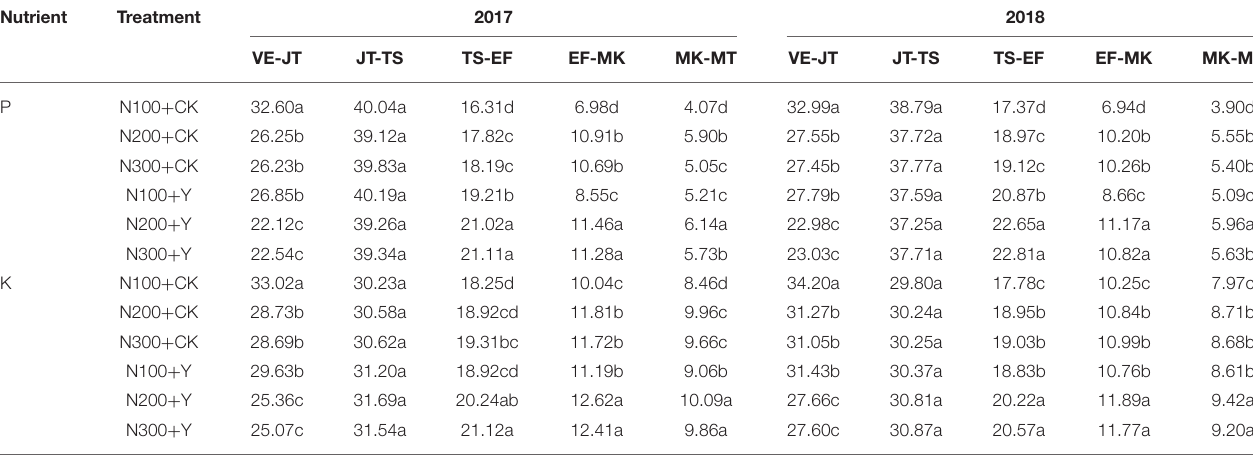
TABLE 5 | Effects of chemical control and nitrogen fertilizers on the proportion of P and K accumulation (%) at different maize growing stages in 2017 and 2018. Nutrient